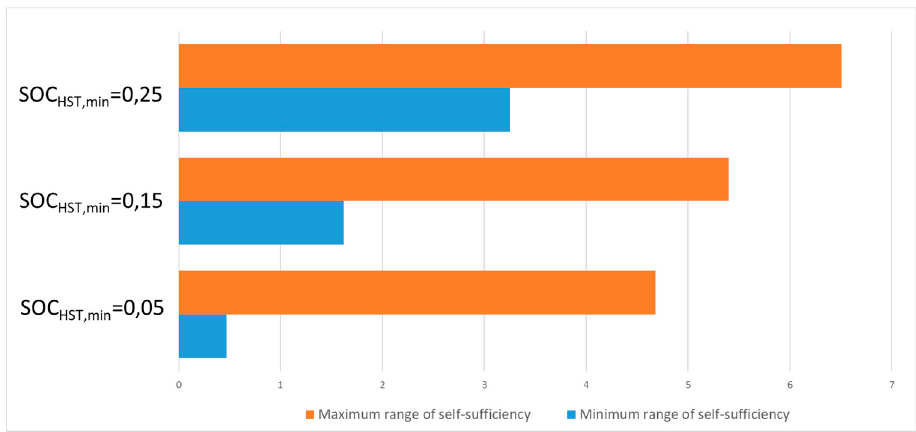
Figure 8. Variation of self-sufficiency ranges as a function of selected c 3 constraint (see Figure 7 caption and Section 3.2).